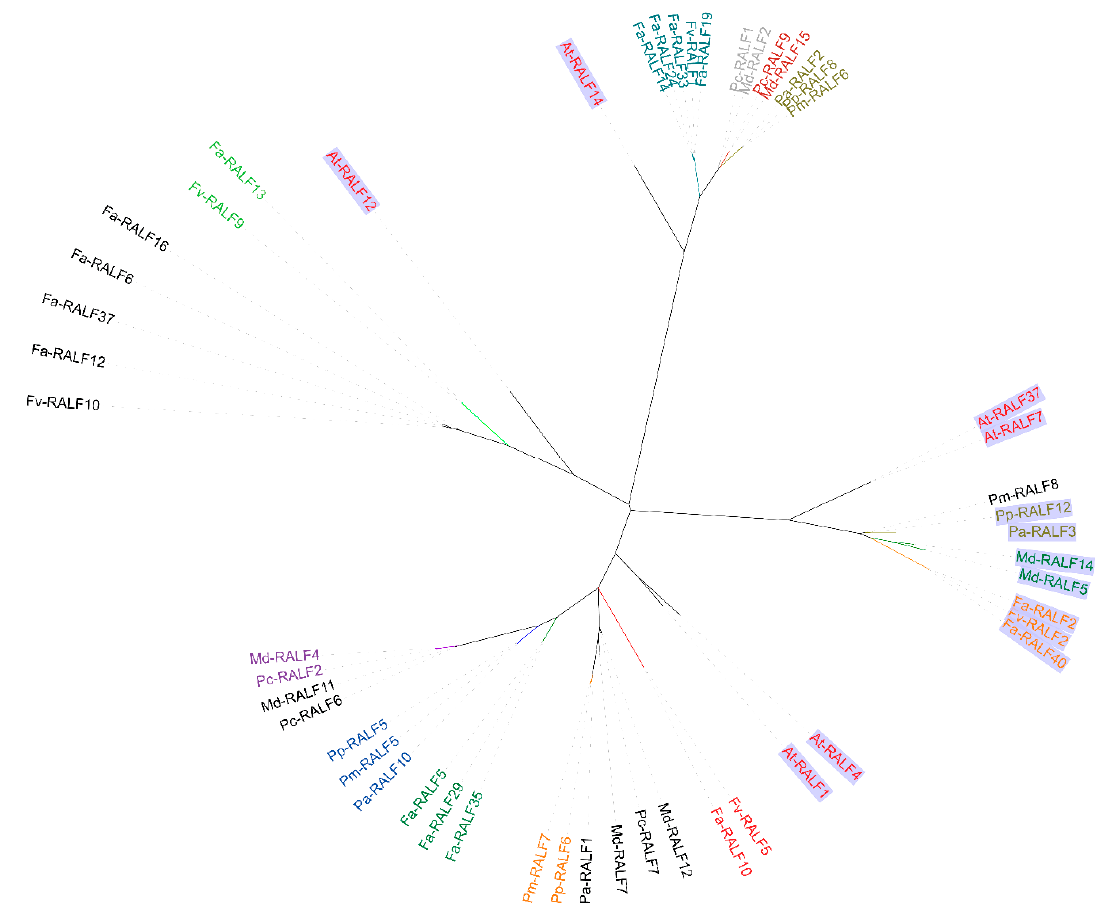
Figure 3. The maximum-likelihood phylogenetic tree of 51 mature RALF genes examined in the present study. RALF genes from Arabidopsis marked with the same color and background, and the same gene pair with the same mark.